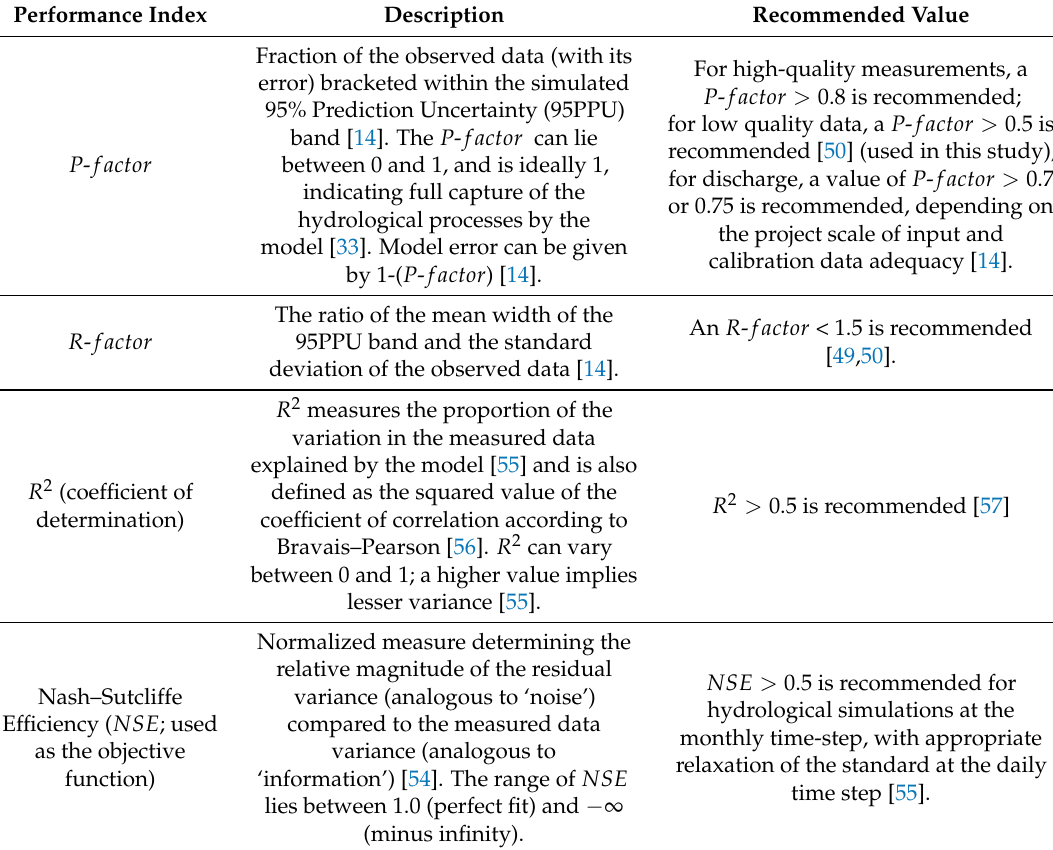
Table 2. Performance criteria followed in the SUFI2